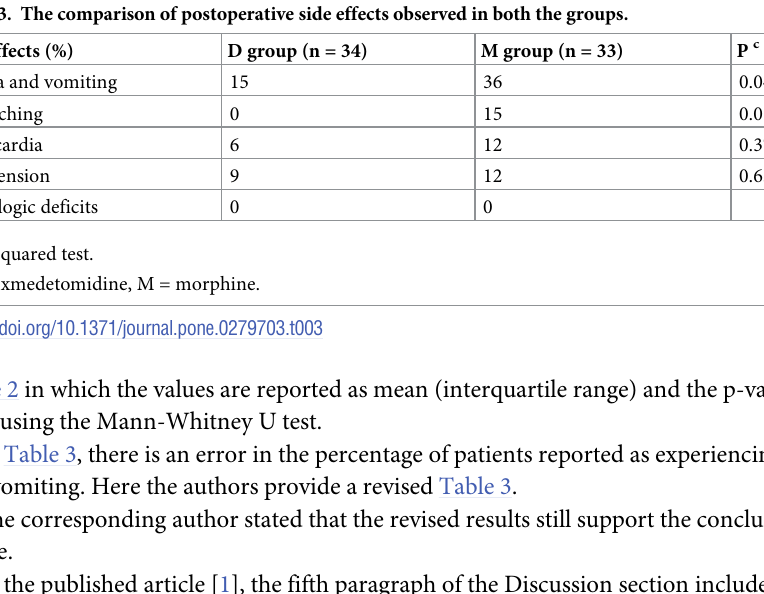
The time to the first analgesic a The total dose of analgesic d a Values are mean ± SD. d Values are median (interquartile range) b Independent two-sample t-test e Mann-Whitney U test. D = dexmedetomidine, M = morphine, VRS = verbal rating